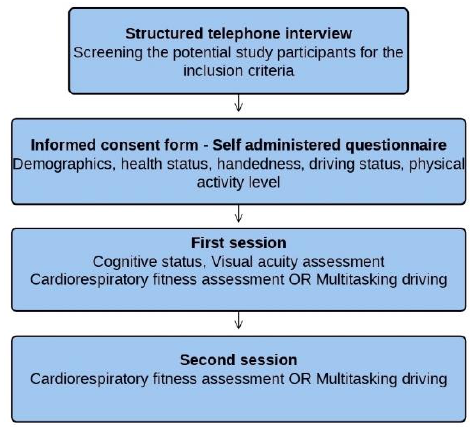
Figure 1. Experiment flow